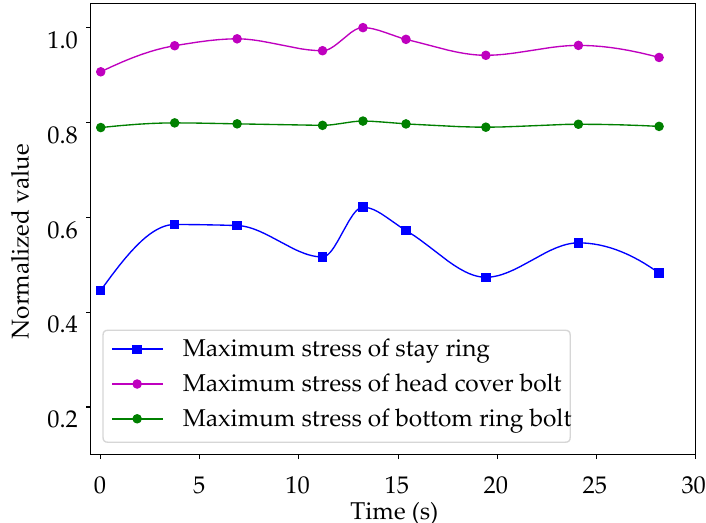
Figure 20. Comparison of the maximum stresses of the stationary structures during load